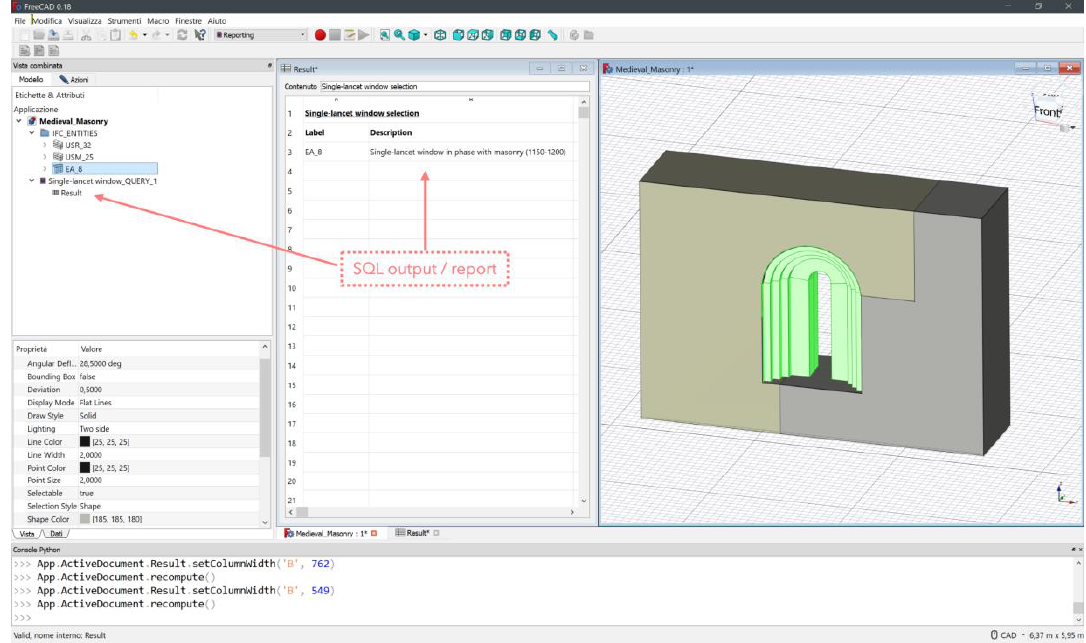
Figure 18. SQL query in order to investigate single-lancet window IFC custom role and its description, referring to the medieval wall: on the left side are the saved single-lancet window_query_1 and the related datasheet report with the query result.